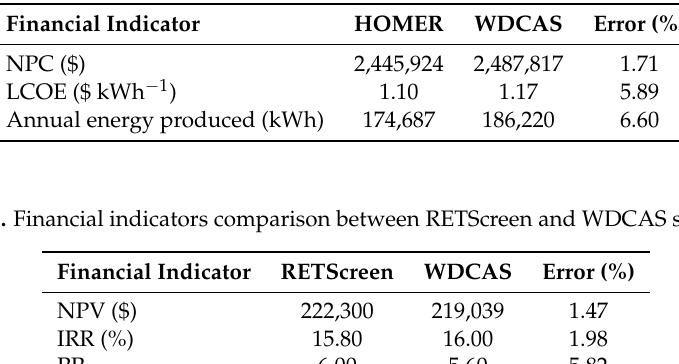
Table 2. Financial indicators comparison between HOMER and WDCAS software.